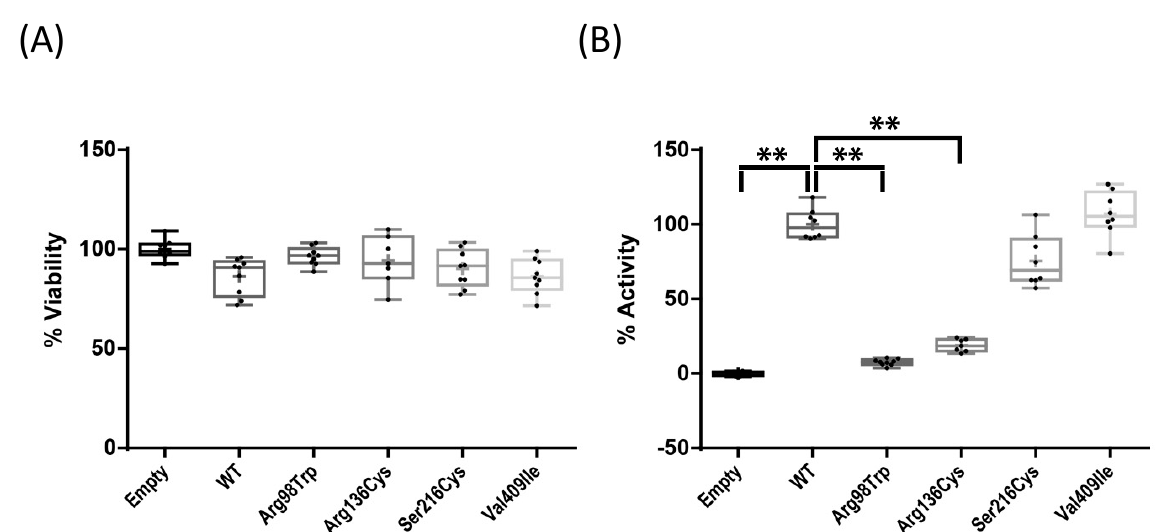
Figure 2. ( A ) Viability of cells transfected with the variants normalized to that of cells transfected with the empty vector, arbitrarily set at 100%. ( B ) Enzymatic activity of the CYP1A1 protein WT and with the variants Arg98Trp, Arg136His, Ser216Cys, and Val409Ile transfected in Saos-2 cells, normalized to the wild-type activity, arbitrarily set at 100% (** p < 0.01). All experiments were performed thrice including three replicas each and p values < 0.05 were considered significant.